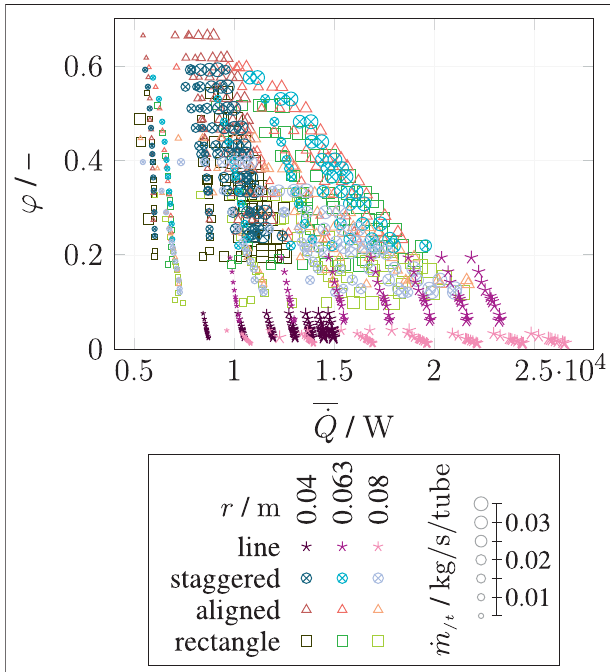
FIGURE 8 | Radiative heat fl ux ratio q ( r ) in relation to the mean heat fl ux per tube _ Q . The symbol (and its color family) indicates the con fi guration of the data point. Shades of the respective color indicate the inner tube radius r . The symbol size indicates the mass fl ow rate _ m / t of fl ue gas per reforming tube.